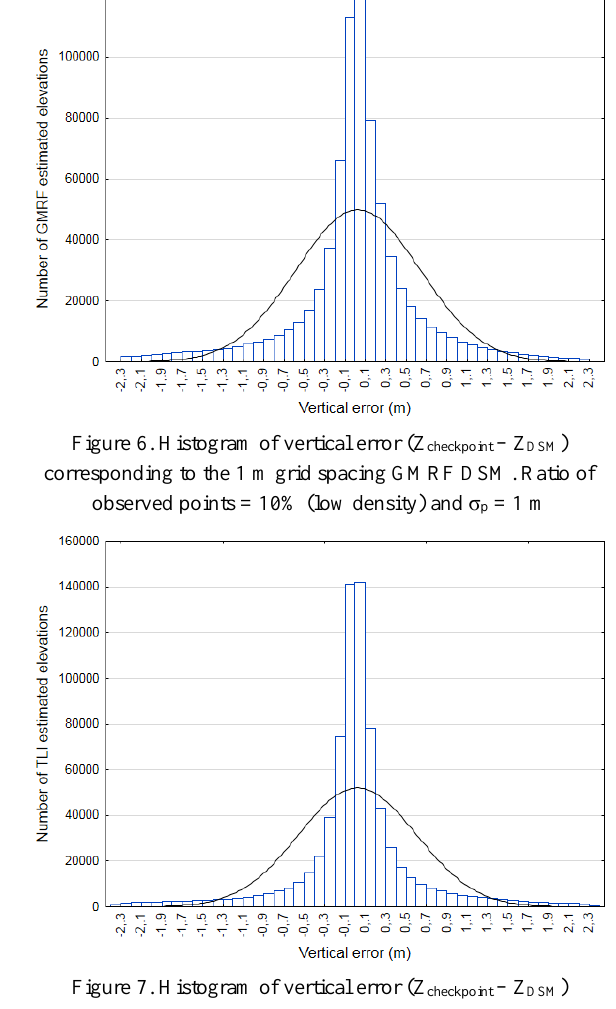
Figure 7. Histogram of vertical error (Z checkpoint – Z DSM ) corresponding to the 1 m grid spacing TLI DSM. Ratio of observed points =